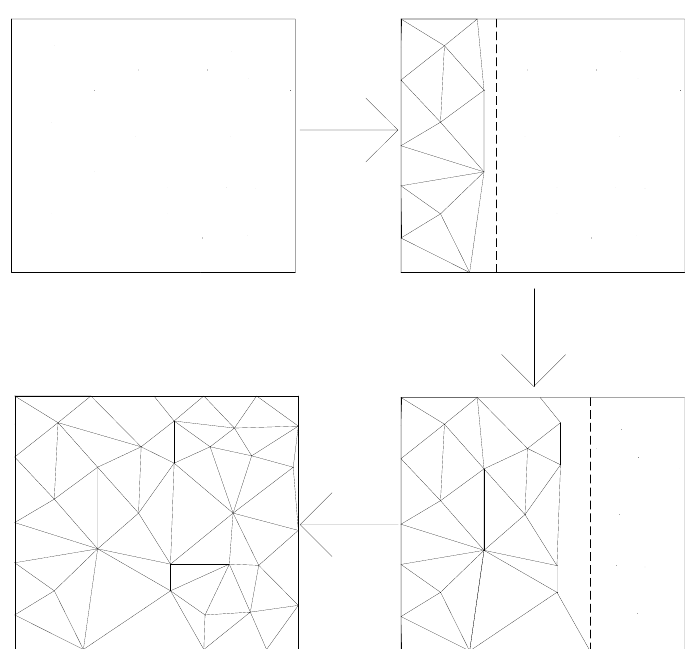
Figure 4. Improved Delaunay triangulation algorithm.